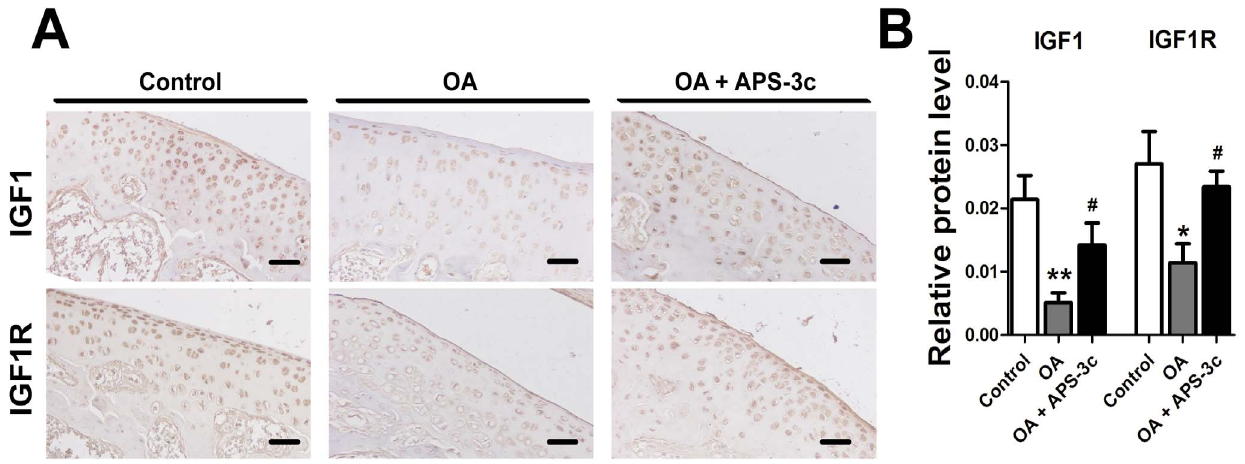
Figure 5. APS-3c stimulated expression of insulin like growth factor (IGF1) and its receptor (IGF1R) invivo . Protein expression of IGF1 and IGF1R were detected in rat cartilage and relative protein level of IGF1 and IGF1R was presented as mean optical density of each chondrocyte.